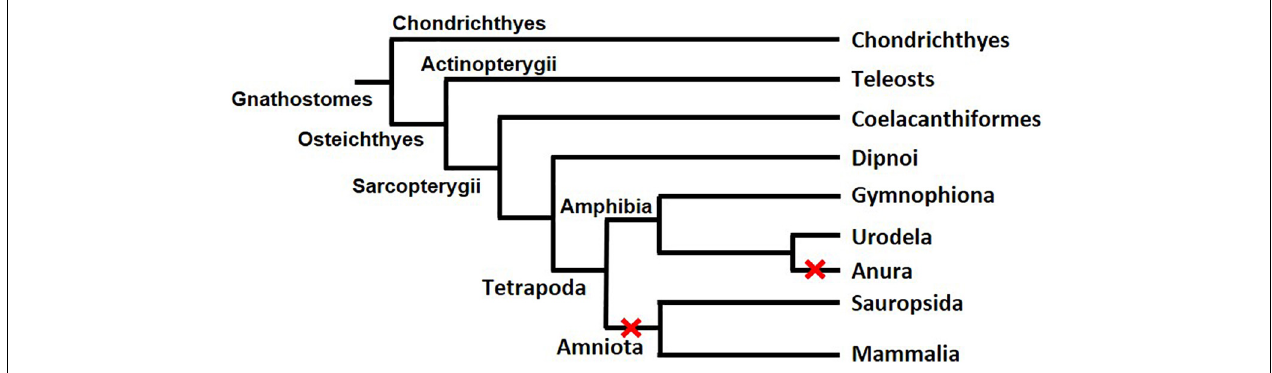
FIGURE 3 | The evolution of gsdf in Gnathostomes. The two red X signs indicate two events of gsdf losses during the evolution of Tetrapoda. The figure is taken from a published article with permission (Biscotti et al.,